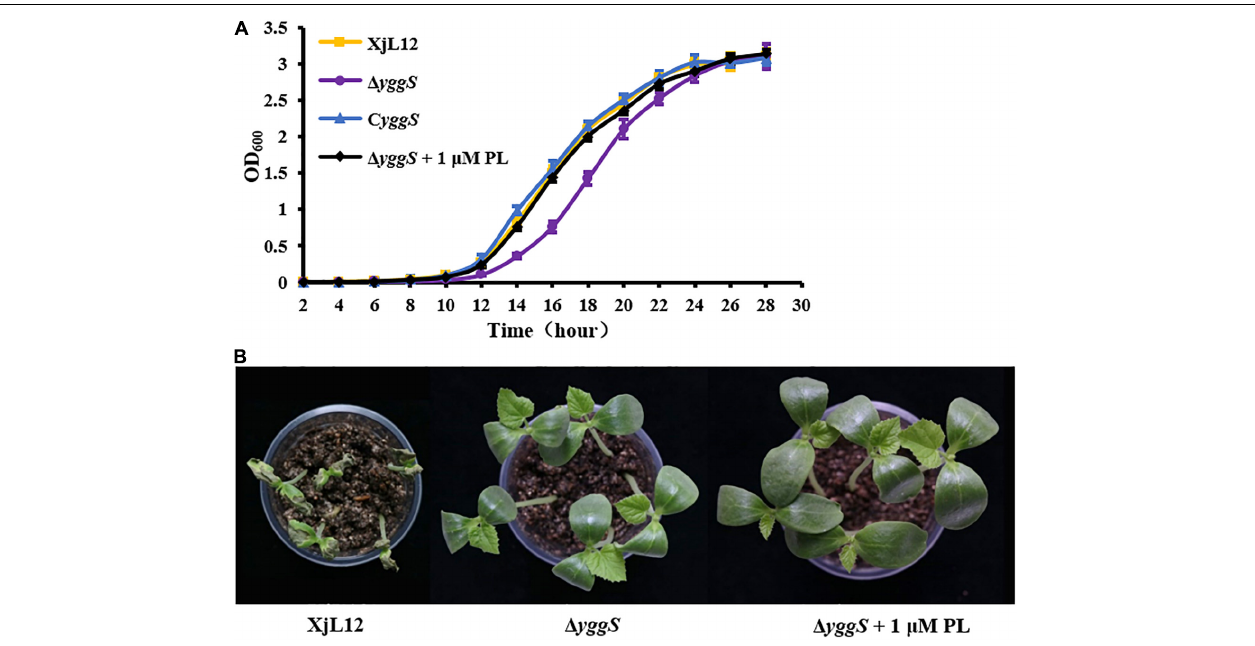
FIGURE 5 | Effect of pyridoxal (PL) on (cid:49) yggS growth in LB and virulence on melon seedlings. (A) Assay of A. citrulli growth rate. All strains were cultured overnight, diluted to OD 600 = 0.1 with sterilized water, and then transferred to fresh LB at a ratio of 1:100. Optical density of cell suspensions was measured at 2 h intervals. The data points represent means and the tines represent the standard errors of the mean for three experiments. Each experiment was repeated three times. (B) Effect of yggS on virulence of A.citrulli on melon cotyledons through exogenous addition of PL. (cid:49) yggS suspension ( ∼ 1 × 10 5 CFU/mL) mixed 1 µ M PL was injected into cotyledons of seedlings, and XjL12 and (cid:49) yggS were used as controls. The images represent the seedlings at 5 days post-inoculation. XjL12: wild-type strain, (cid:49) yggS : yggS deletion mutant; C yggS : complemented strain of (cid:49) yggS .